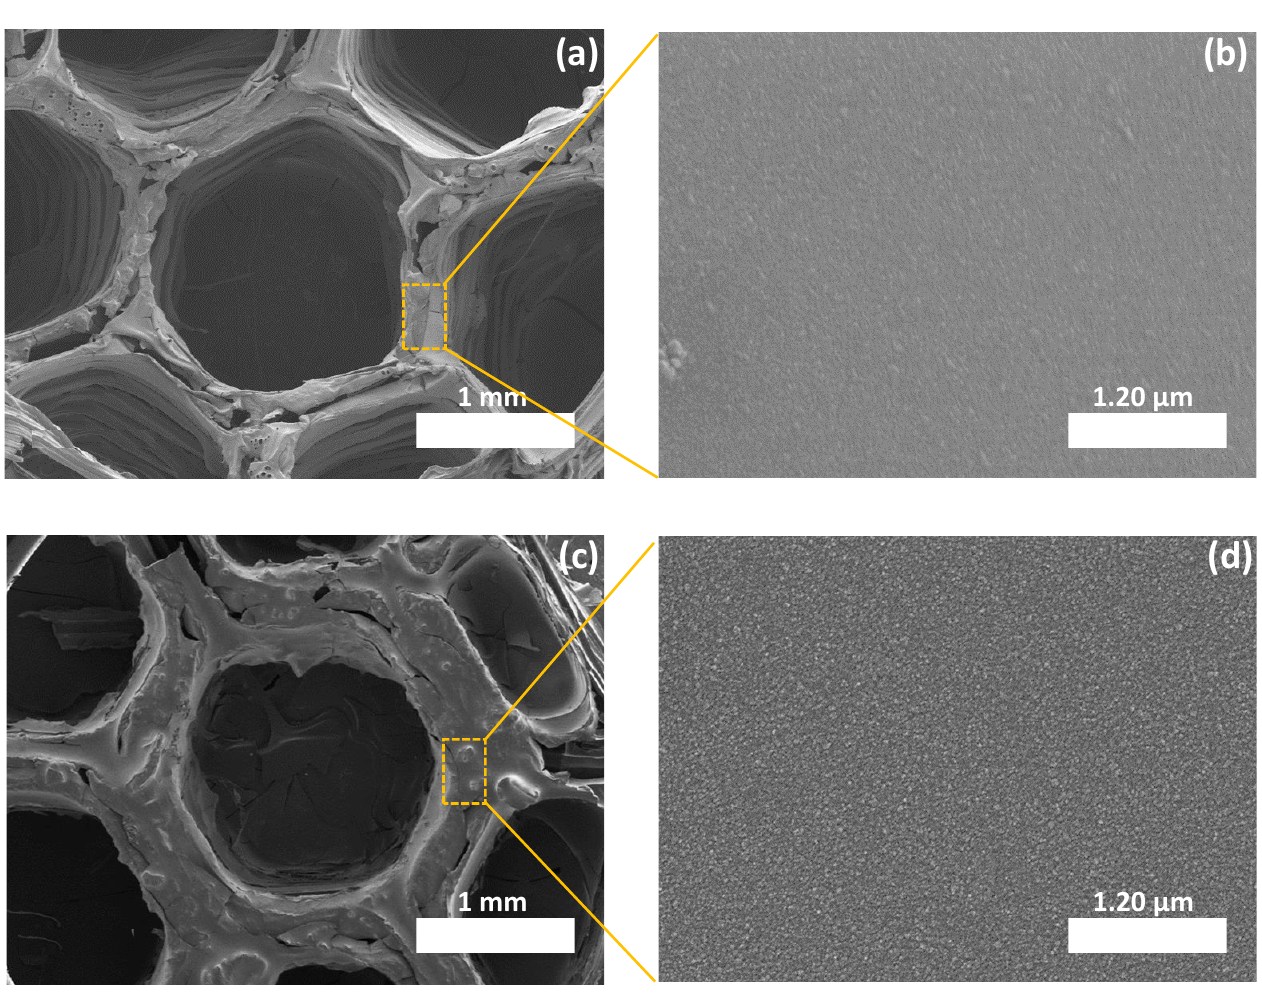
Figure 2. ( a ) SEM image of a SiCN cell. ( b ) Magnified image of a SiCN single wall. ( c ) SEM image of a SiC cell. ( d ) Magnified image of a SiC single wall.